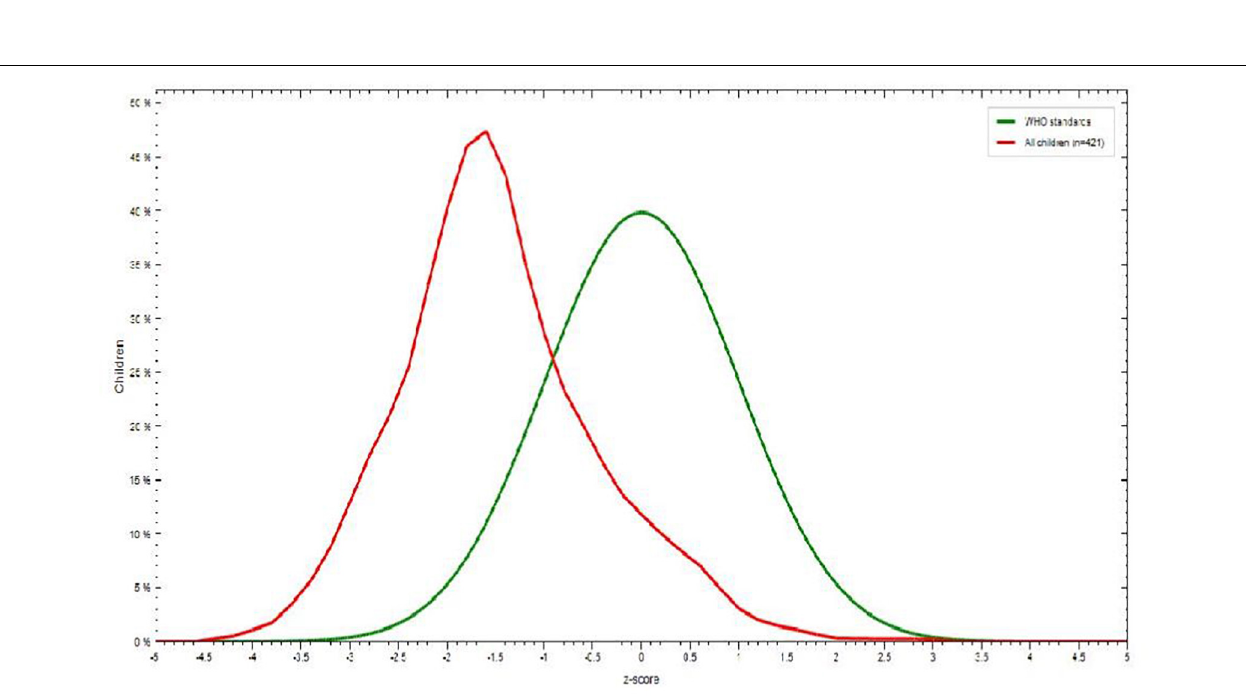
Frontiers in Pediatrics |